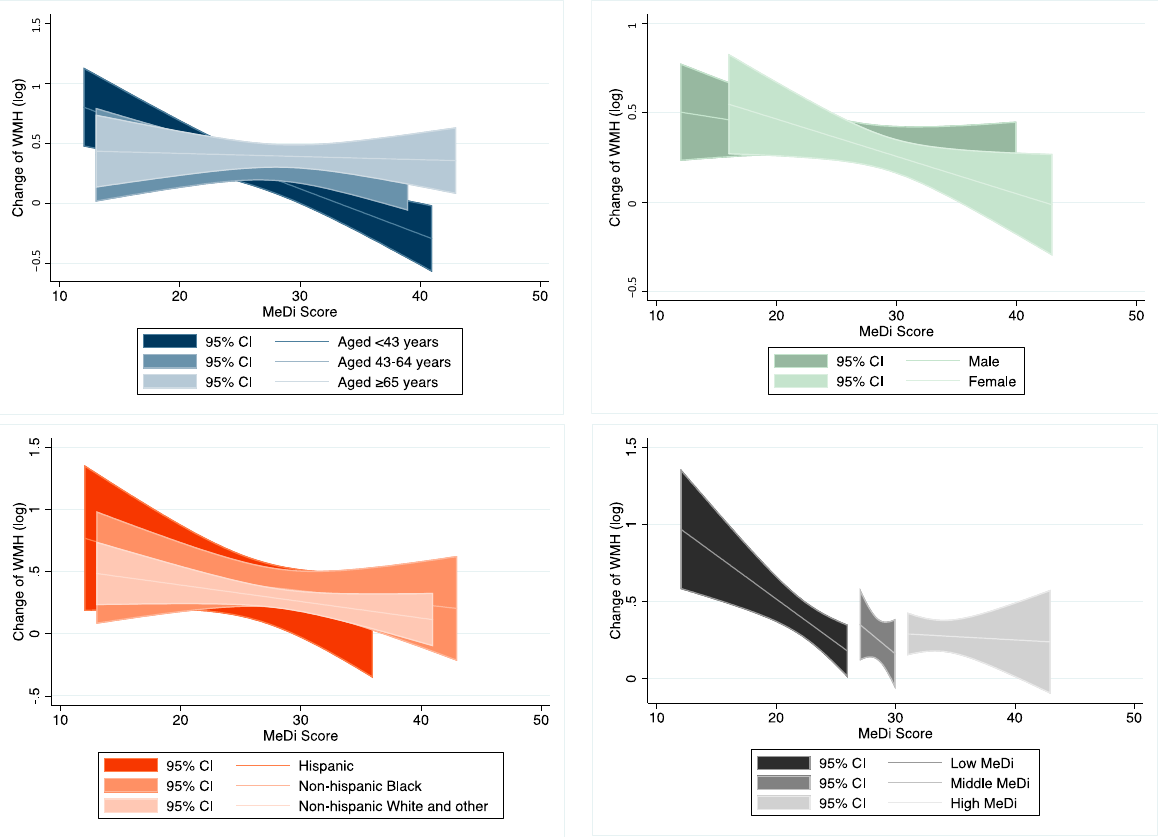
Figure 3. Relationship between Mediterranean diet score and change in white matter hyperintensity by age, gender, race/ethnicity, and tertile MeDi group.